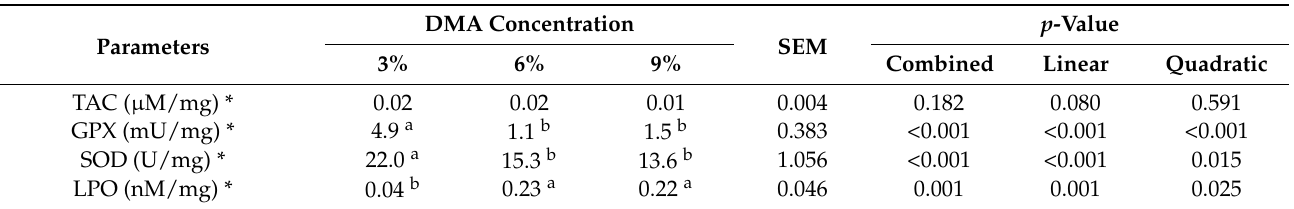
Table 5. Effect of dimethyl acetamide (DMA) concentration in semen freezing extender on the antioxidant biomarkers of rooster sperm after thawing.